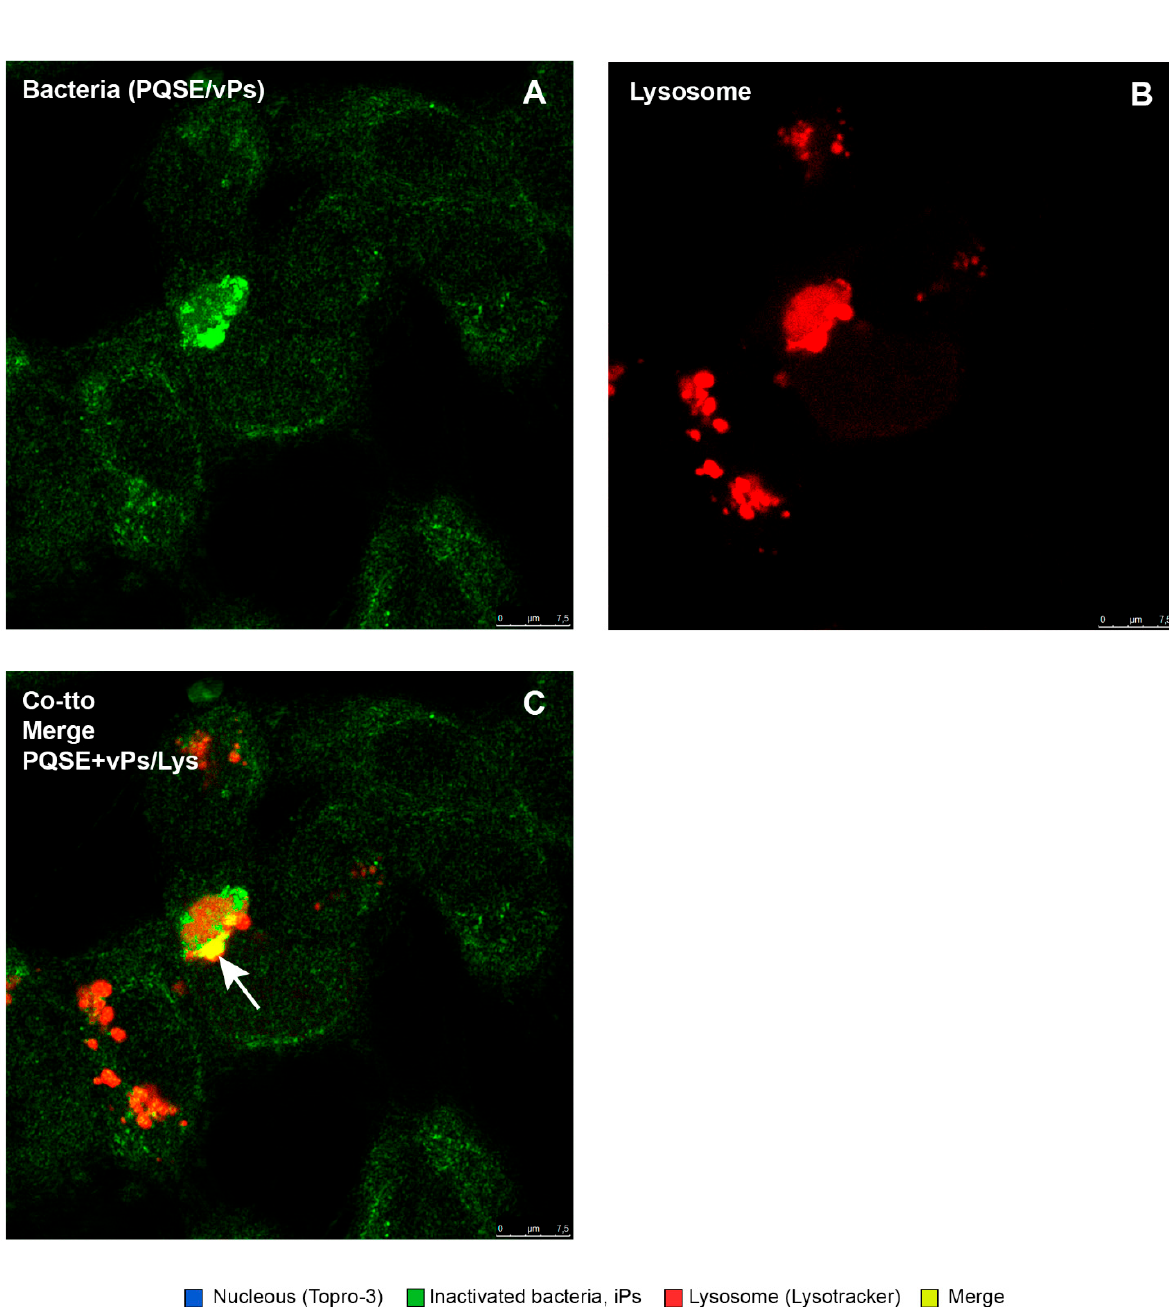
Figure 13. Location of P. salmonis in SHK-1 cells in a co-treatment with 0.5 µg/mL of PQSE (24 hpi) . Photomicrographs show the location of the virulent P. salmonis (vPs) strain LF89 in SHK-1 cells in a co-treatment with PQSE and simultaneous challenge with the bacterium (vPs) for 4 h. ( A ) The nuclei of the cells marked with TOPRO-3 (blue) can be observed. ( B ) Virulent bacteria (vPs) (green) can be observed. ( C ) Lysosomes marked with Lysotracker Red DND-99 (red) can be observed, and ( D ) vPs bacteria located inside lysosomes were observed to be orange-yellow as an indicator that there was maturation of the phagosome that contained the bacterium and phagosome–lysosome fusion.